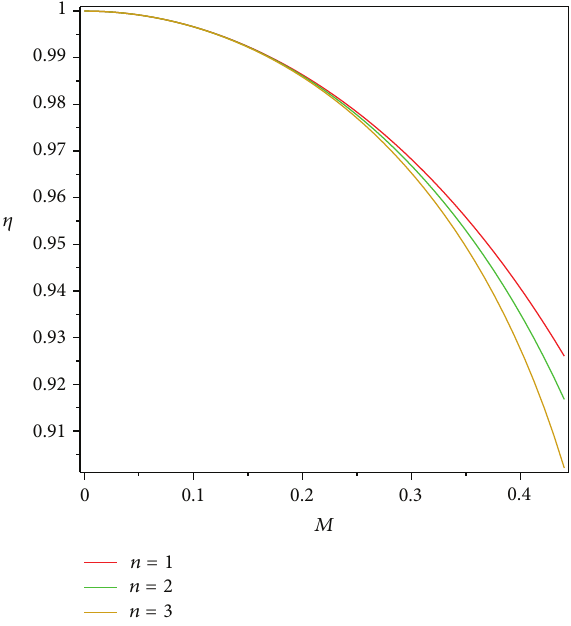
Figure 10: Efficiency 𝑓(𝑥) = 1 , 𝑛 ̸=𝑚 as given in solution (42) in a fin with varying values of 𝑛